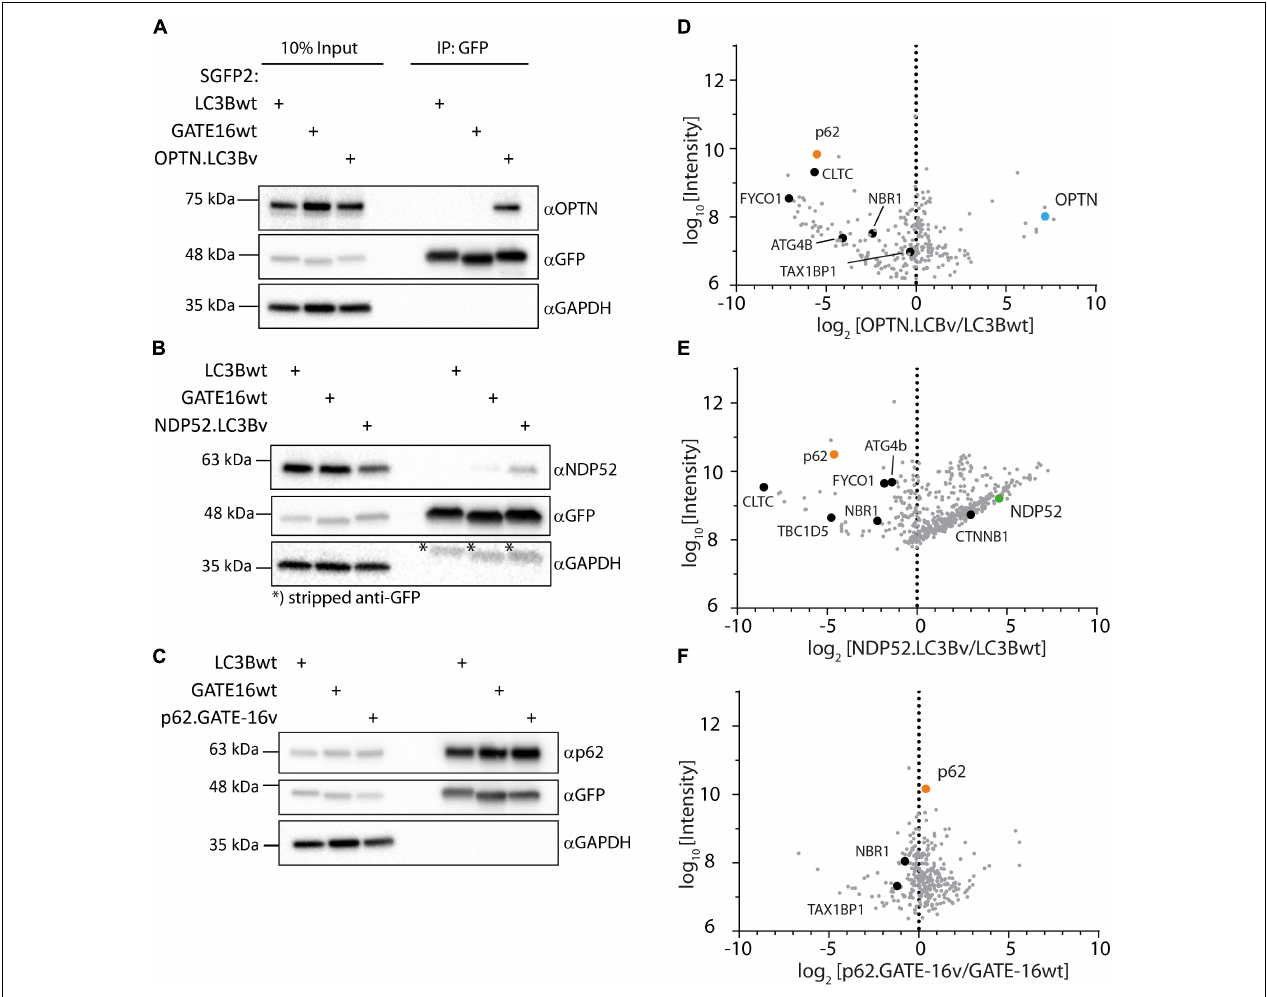
FIGURE 4 | Engineered LC3B and GATE-16 variants co-immunoprecipitate endogenous OPTN, p62 or NDP52. (A–C) Co-immunoprecipitation (Co-IP) of (A) OPTN, (B) NDP52, or (C) p62 binding variants and corresponding wt controls expressed as SGFP2 fusion proteins in stable inducible HeLa cells. Western blots were probed with indicated antibodies. (D–F) Mass spectrometry of Co-IPs using anti-GFP beads from stable HeLa cells expressing inducibly SGFP2 fusion proteins of LC3Bwt, GATE-16wt, OPTN.LC3Bv or p62.GATE-16v. In case of NDP52.LC3Bv, HeLa cells were transiently transfected with SGFP2 fusion constructs either expressing LC3Bwt or NDP52.LC3Bv. Detected proteins (gray) were plotted as log 2 enrichment vs log 10 intensity. Endogenous OPTN (blue), p62 (orange), NDP52 (green) and other LIR containing proteins (black) are shown as